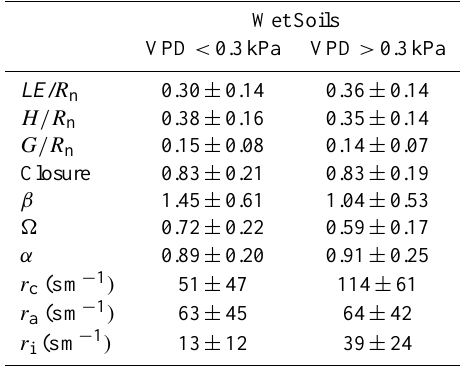
Table 5. Average midday energy balance partitioning and bulk pa- rameters during VPD below and above 0.3kPa at the CM (1999– 2003) and BE (2006) sites, during wet, but not inundated, near- surface soil moisture conditions (15 July–15